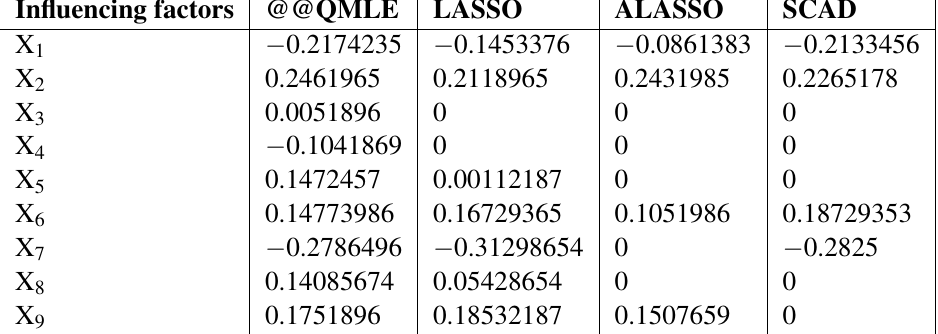
Table 1 Data parameter estimation of crime influencing